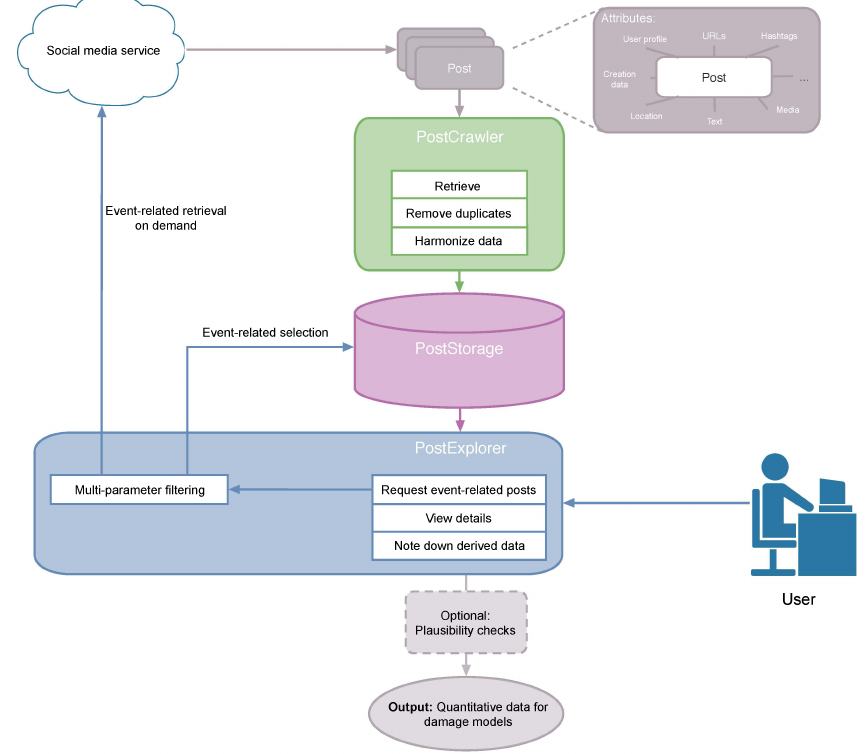
Figure 1. PostDistiller system